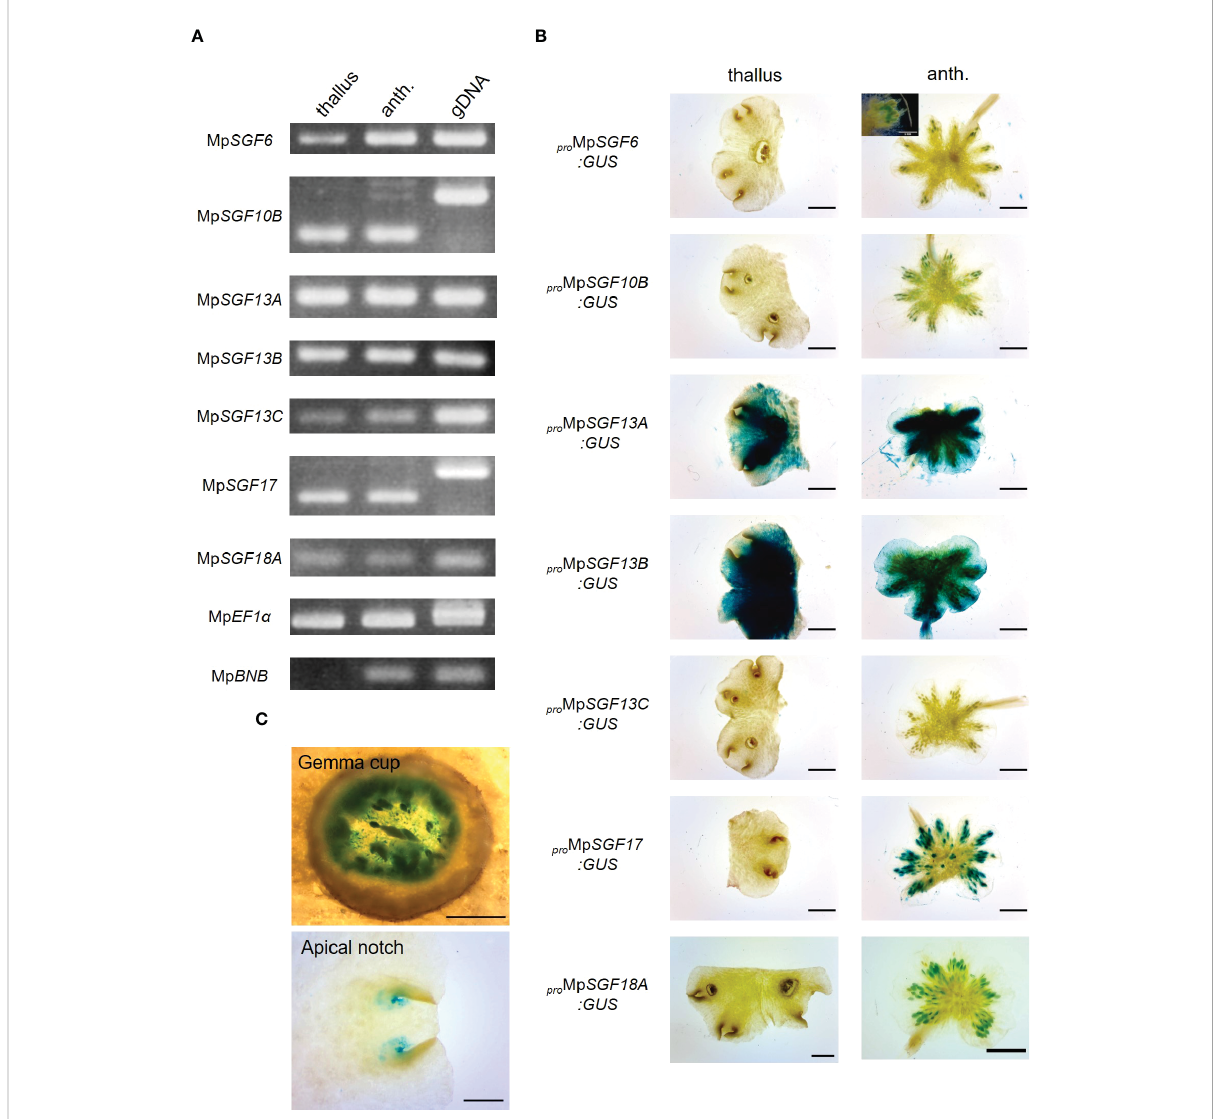
FIGURE 2 Expression patterns of Mp SGF s in M. polymorpha . (A) RT-PCR in 2-week-old thallus (thallus) and antheridiophore (anth.). Mp EF1 a is used as an internal control. Mp BNB is used as a marker gene for antheridiophore (Yamaoka et al., 2018). (B) Representative images of the GUS reporter assay for expression patterns of MpSGFs. Two-week-old thalli and antheridiophores were observed for the visualization of promoter activities. Bars = 2 mm. For pro Mp SGF6:GUS , a magni fi ed image around antheridia is shown in the inset, bar = 1 mm. (C) Magni fi ed images of GUS signal in the bottom of gemma cups and apical notches of pro Mp SGF10B:GUS plants. Bars = 0.5